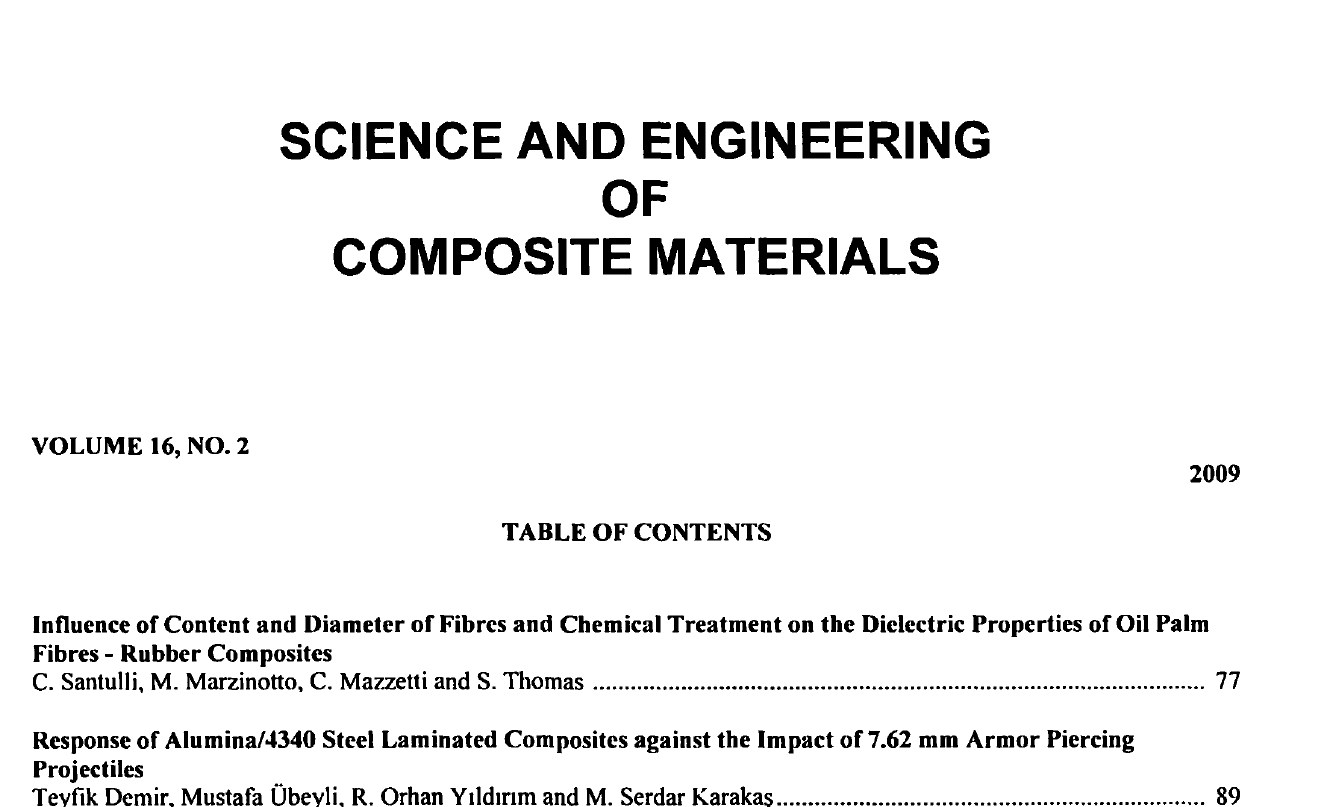
Influence of Content and Diameter of Fibres and Chemical Treatment on the Dielectric Properties of Oil